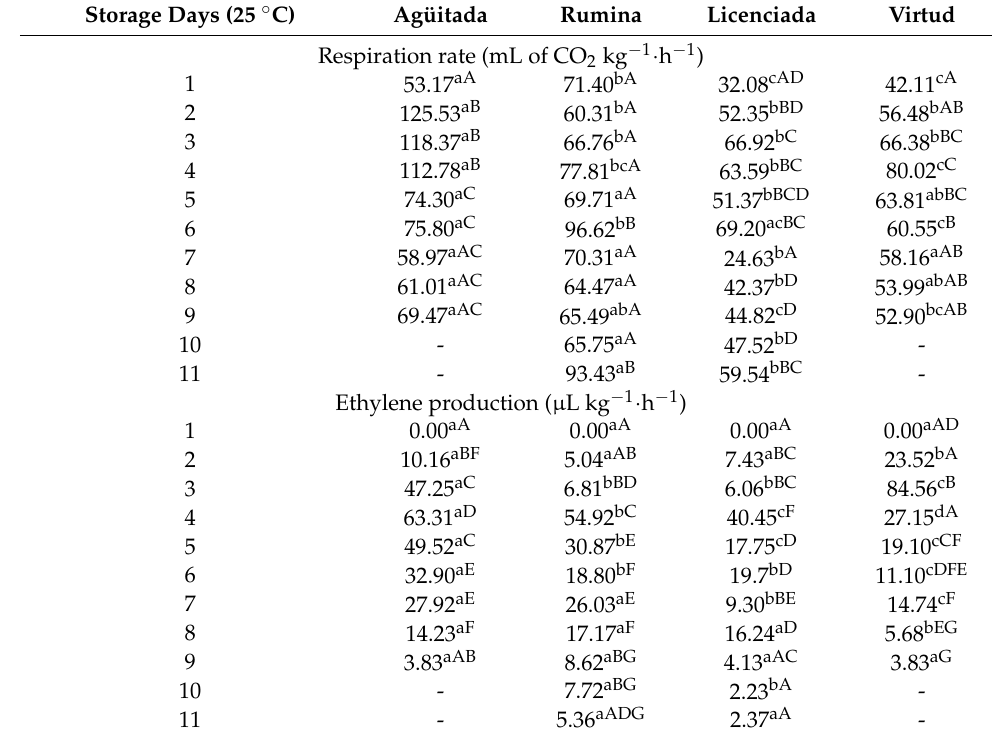
Table 2. Respiration rate, ethylene production rate, and physiological weight